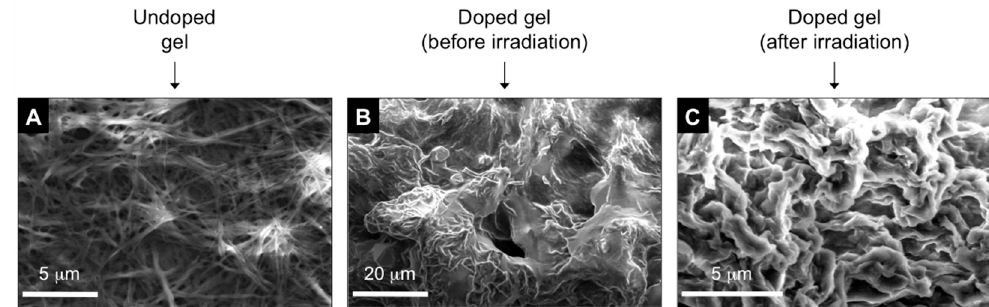
Figure 3. Representative scanning electron microscopy images of some xerogels prepared by freeze-drying the corresponding gels: ( A ) gel made of G-1 ( c = 25 g L − 1 ) in EtOAc (0.8 mL); ( B,C ) gel made of G-1 ( c = 25 g L − 1 ), and containing 1,3,5-trimethoxybenzene (16.8 mg, 0.1 mmol), sodium triflinate (62.4 mg, 0.4 mmol), EtOAc (0.8 mL), and diacetyl (0.2 mL).